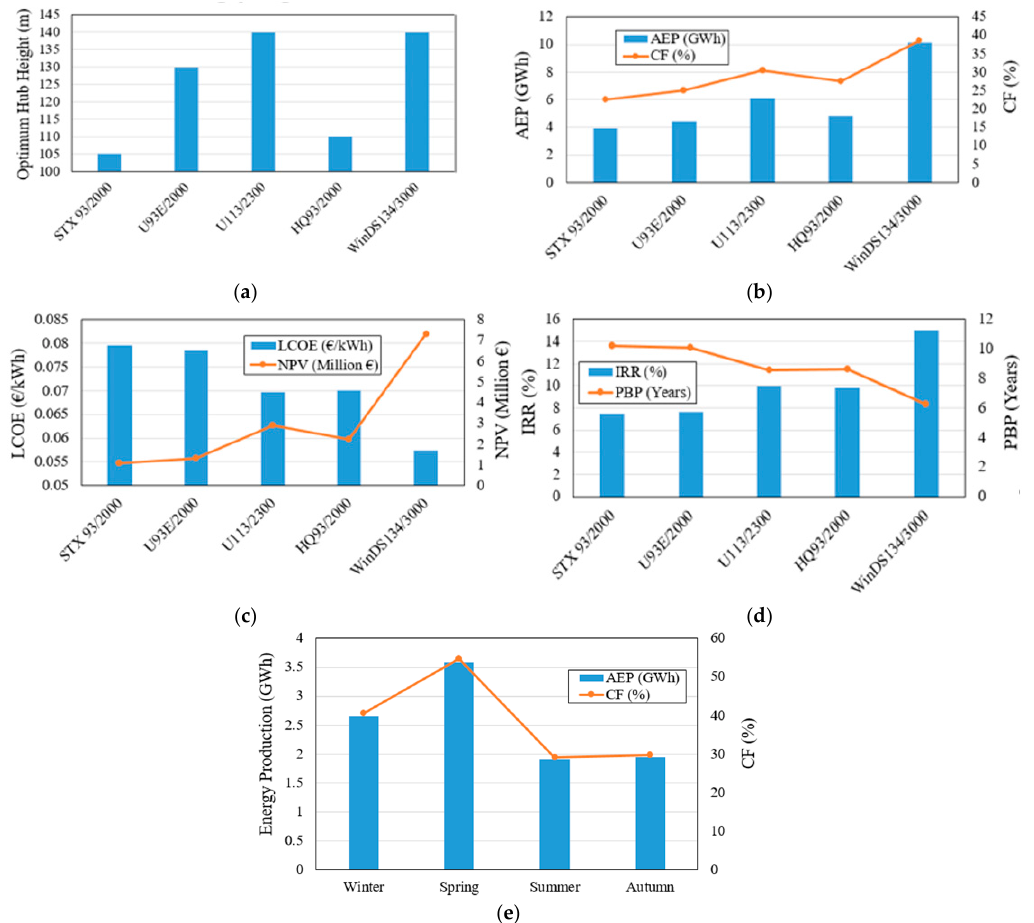
Figure 13. Estimations of important parameters at discount rate of 5% and the optimal hub height for Baengnyeong-do ( a ) optimal hub height; ( b ) AEP & CF; ( c ) LCOE & NPV; ( d ) IRR & PBP; ( e ) Season-wise energy production of WinDS 134/3000.